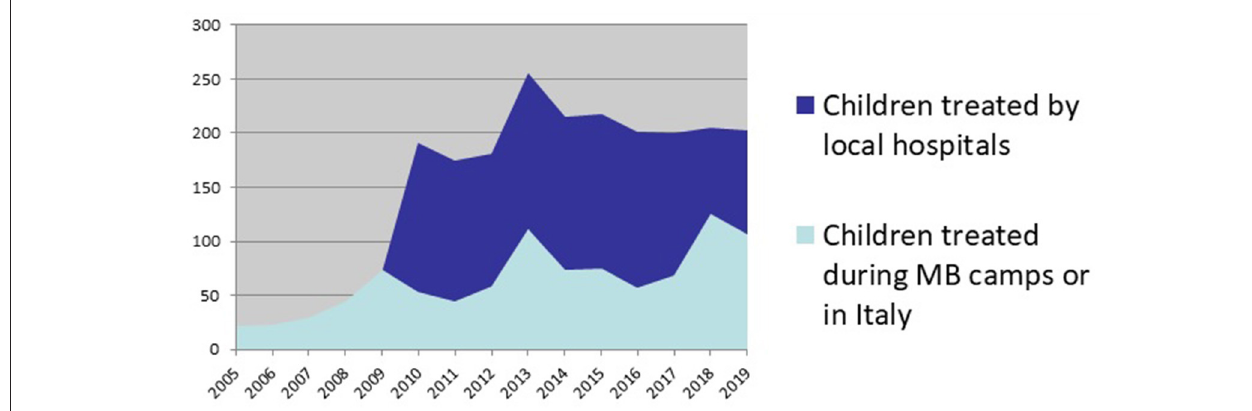
FIGURE 1 | Children treated autonomously by local hospitals or by the MB volunteer healthcare